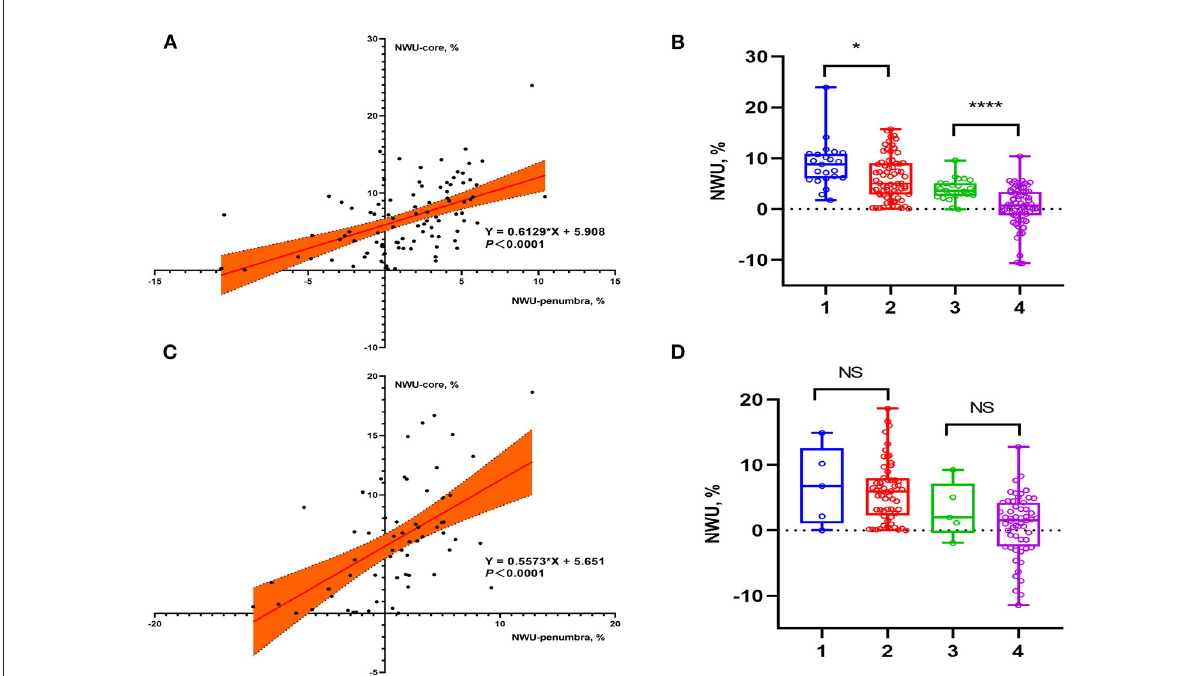
FIGURE2 Data distributions of NWU-core and NWU-penumbra in patients stratified by reperfusion therapies. (A) Scatter plot showed the relationship between NWU-core and NWU-penumbra in patients with MT. (B) Group 1: NWU-core of sICH patients, group 2: NWU-core of non-sICH patients, group 3: NWU-penumbra of sICH patients, group 4: NWU-penumbra of non-sICH patients. Box plot showed that in patients with MT, sICH group had higher NWU-core [8.8 (6.0–10.9) vs. 5.0 (2.8–9.0), P = 0.013] and NWU-penumbra [2.6 (3.6–5.1) vs. 0.7 ( − 1.2 to 3.4), P < 0.001] than those without sICH. (C) Scatter plot showed the relationship between NWU-core and NWU-penumbra in patients without MT. (D) Group 1: NWU-core of sICH patients, group 2: NWU-core of non-sICH patients, group 3: NWU-penumbra of sICH patients, group 4: NWU-penumbra of non-sICH patients. Box plot showed that in patients without MT, there was no statistical difference in NWU-core [6.8 (1.1–12.6) vs. 6.0 (2.3–8.0), P = 0.885] and NWU-penumbra [2.0 ( − 0.4 to 7.2) vs. 1.5 ( − 2.8 to 4.1), P = 0.318] between sICH and non-sICH group. * p < 0.05; ** p < 0.01; *** p < 0.001; **** p <